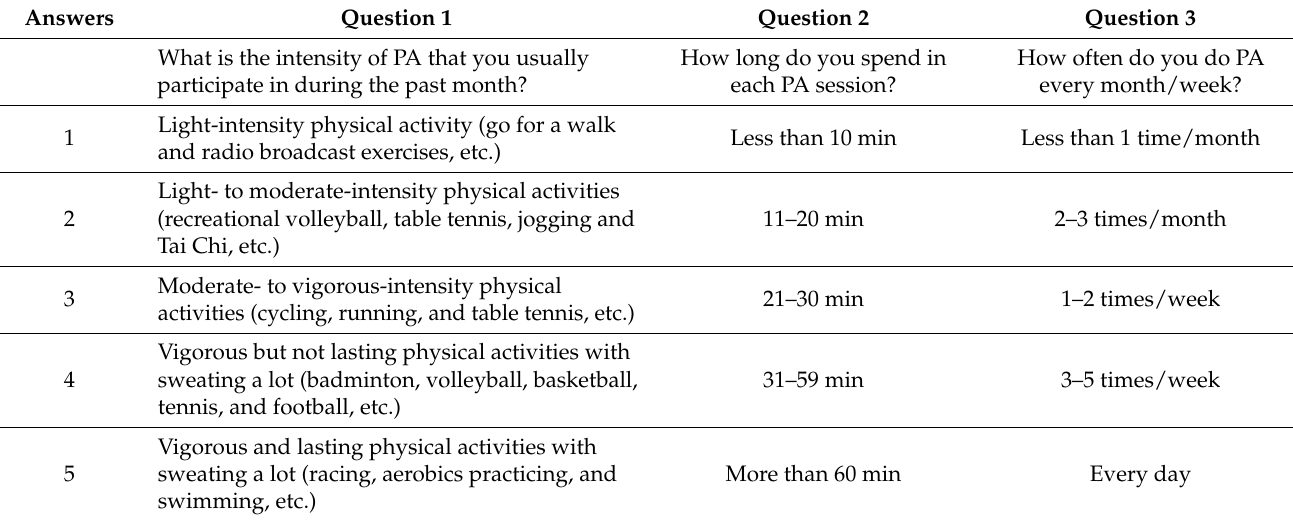
Table A2. PARS-3 questions and answers.